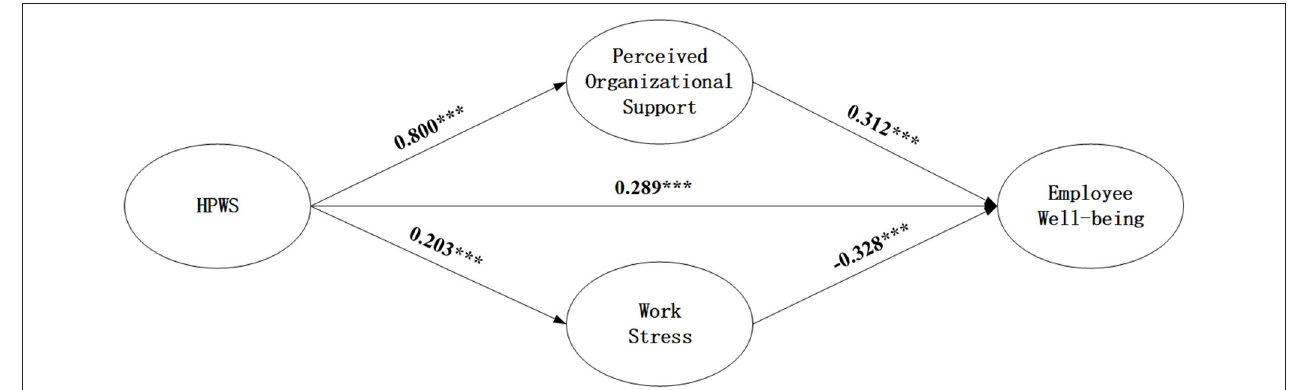
FIGURE 1 | The effect of HPWS on employee